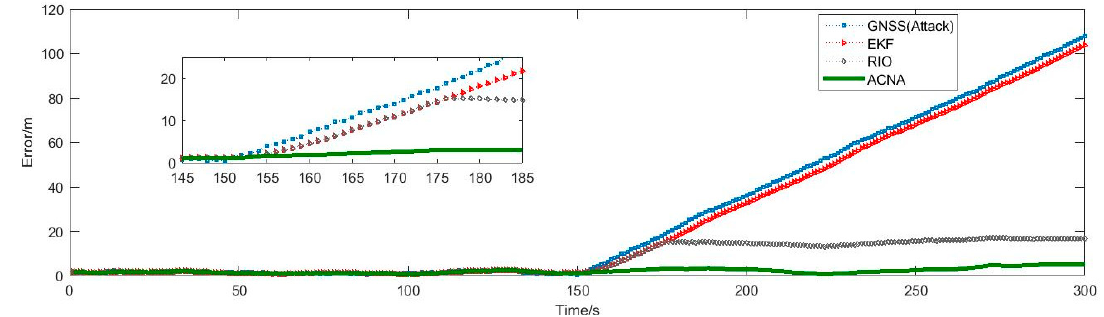
Ψ  . Figure 15. The position error of the three algorithms on data set (cid:101) Ψ 3 . 3